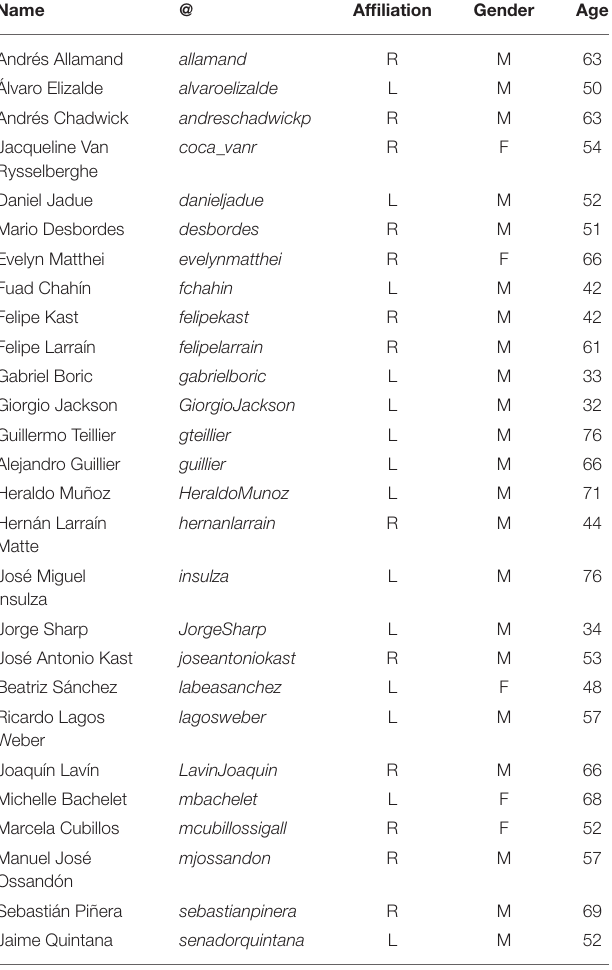
TABLE 2 | Description of considered political figures.